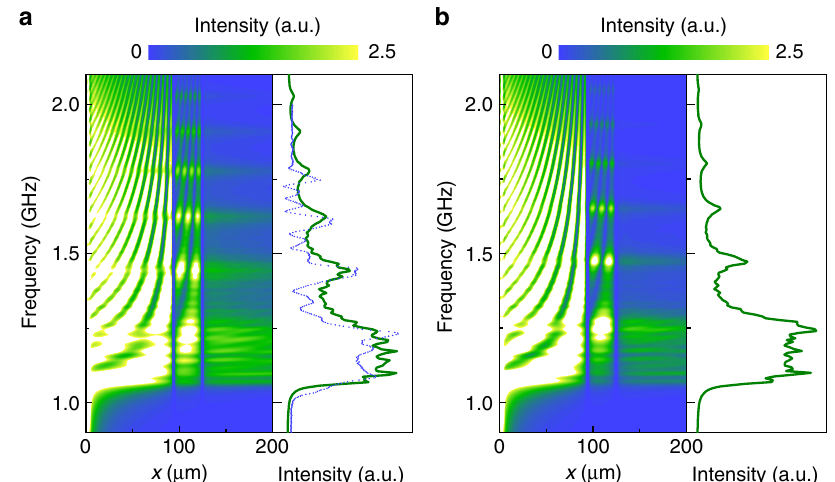
Fig. 7 Simulations for discrete magnonic crystals with only two units. a , b Spatial distribution of spin-wave intensity in a a 30 w 2.5 crystal with a N = 2 CoFeB stripes and b N = 2 airgaps. The right panels show simulated transmission spectra (solid green lines) and an experimental measurement (dashed blue line) for the bicomponent